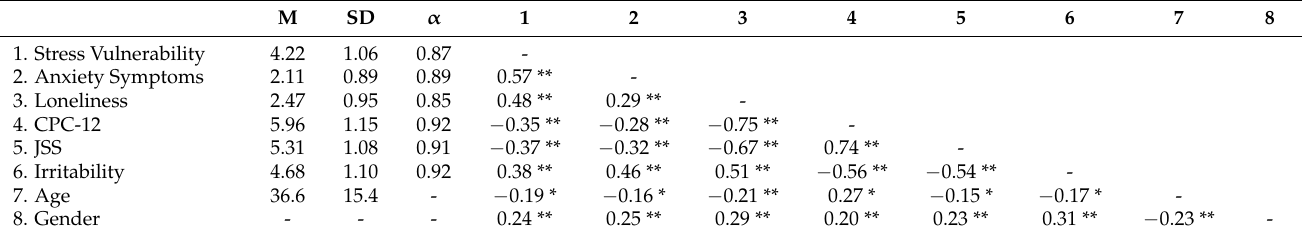
Table 2. Descriptive statistic, correlation, and